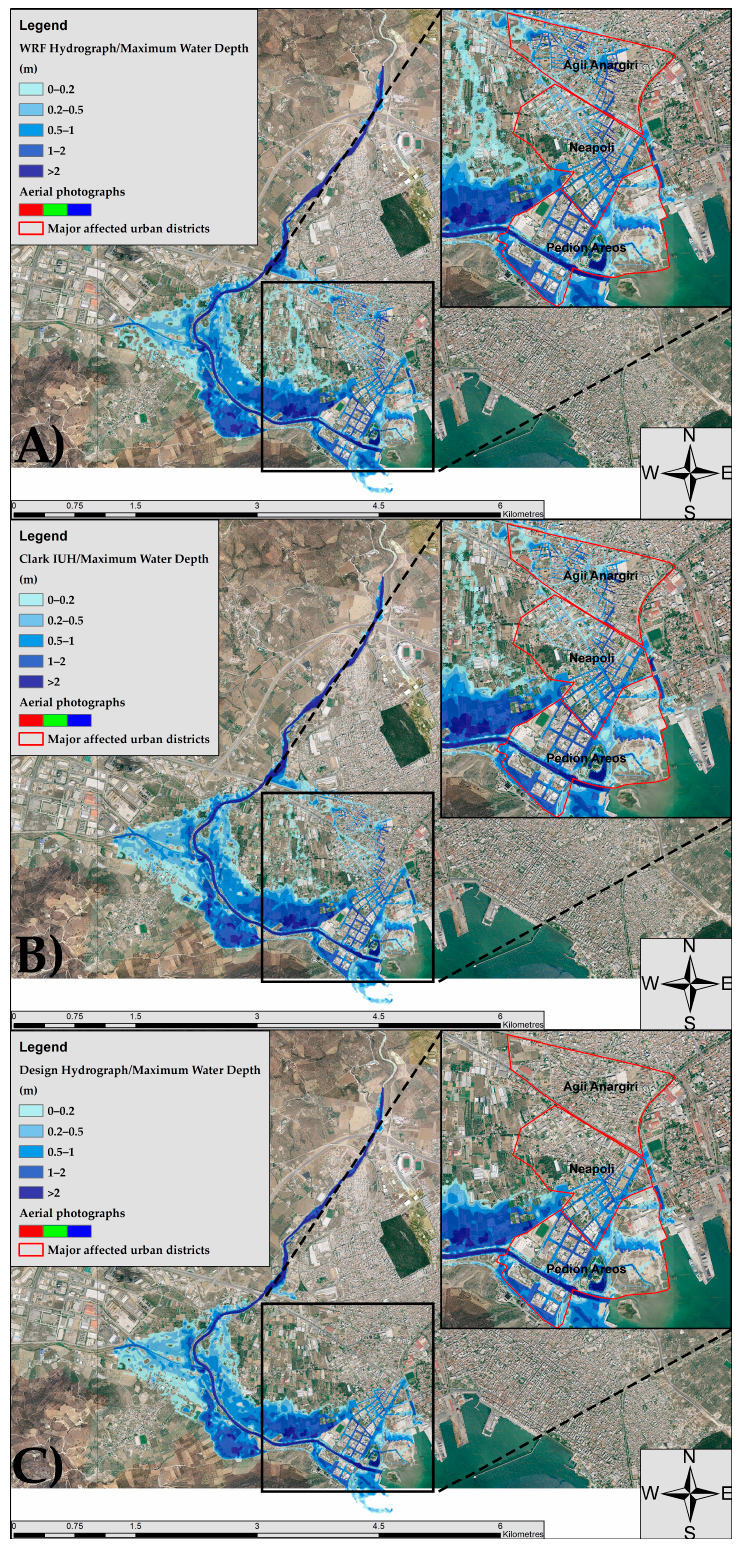
Figure 9. Maximum water depth and flood extent simulated by the 2D HEC-RAS model using the hydrographs: ( A ) WRF hydrograph, ( B ) Clark IUH, ( C ) design hydrograph.